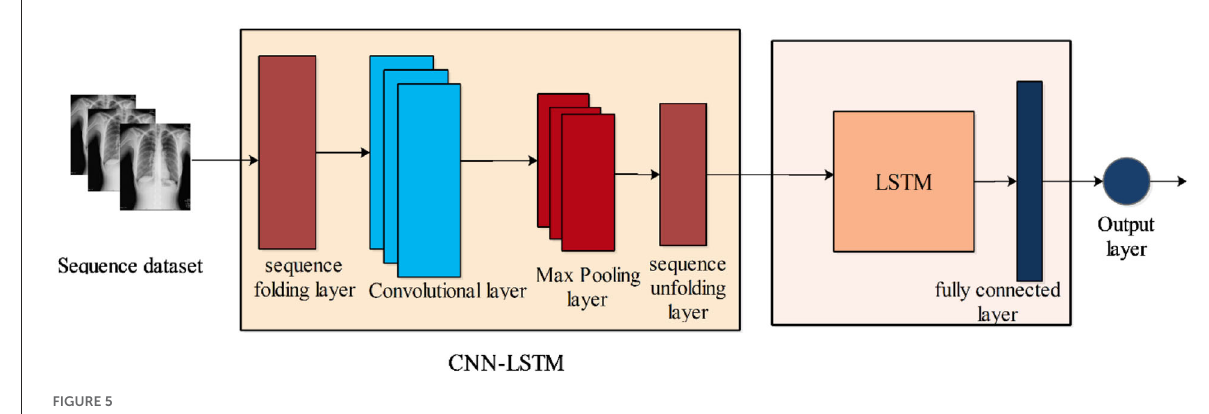
FIGURE5 Proposed CNN-LSTM architecture.